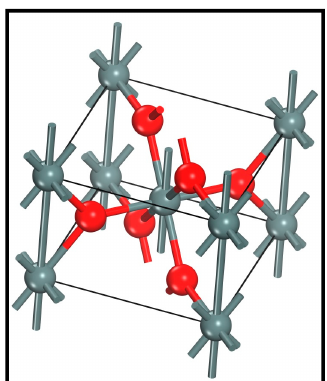
Figure 4. The optimized cassiterite bulk unit-cell (colour codes: Gray—Sn, Red—O).